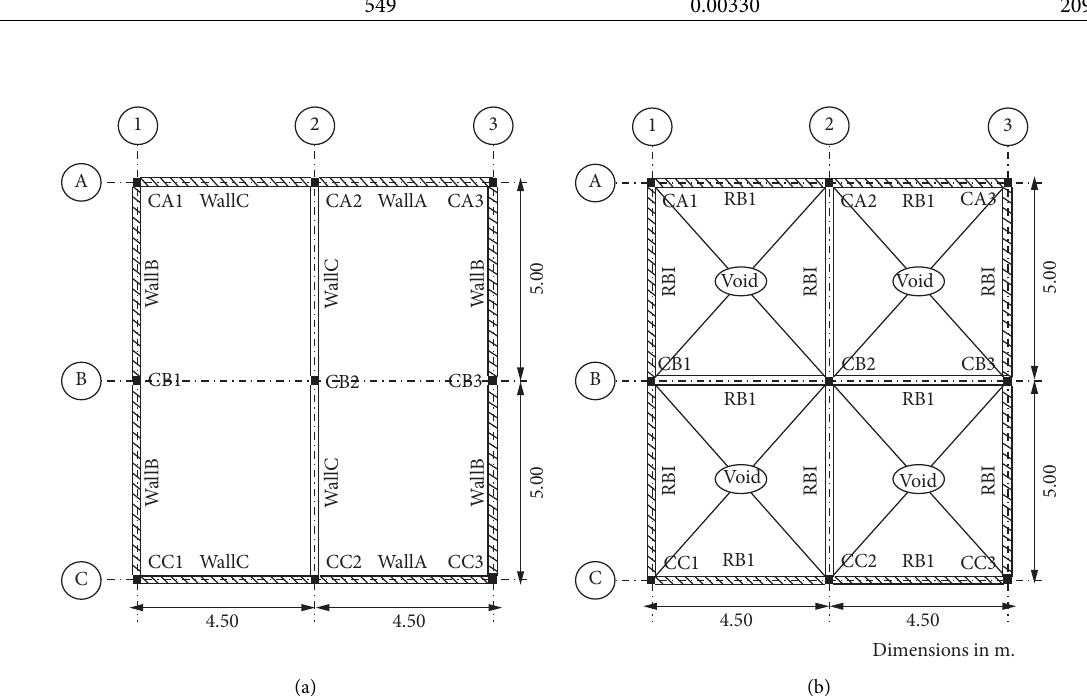
Figure 2: Construction drawing of the building. (a) Floor plan. (b) Roof plan.